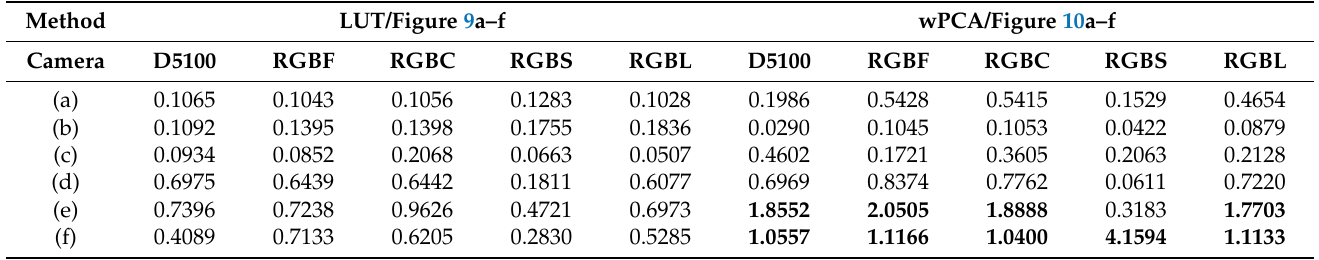
Table 4. The values of ∆ E 00 for the cases shown in Figures 9a–f and 10a–f. The values larger than 1.0 are shown in